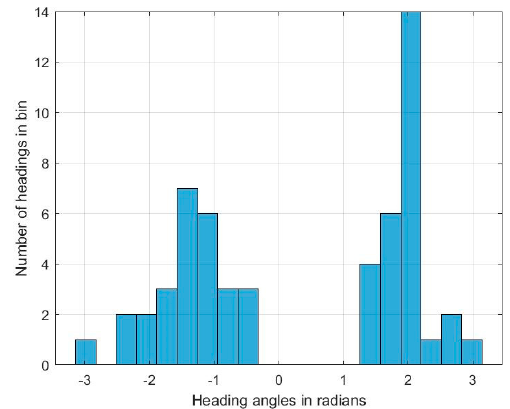
Figure 12. In − step heading distribution histogram.